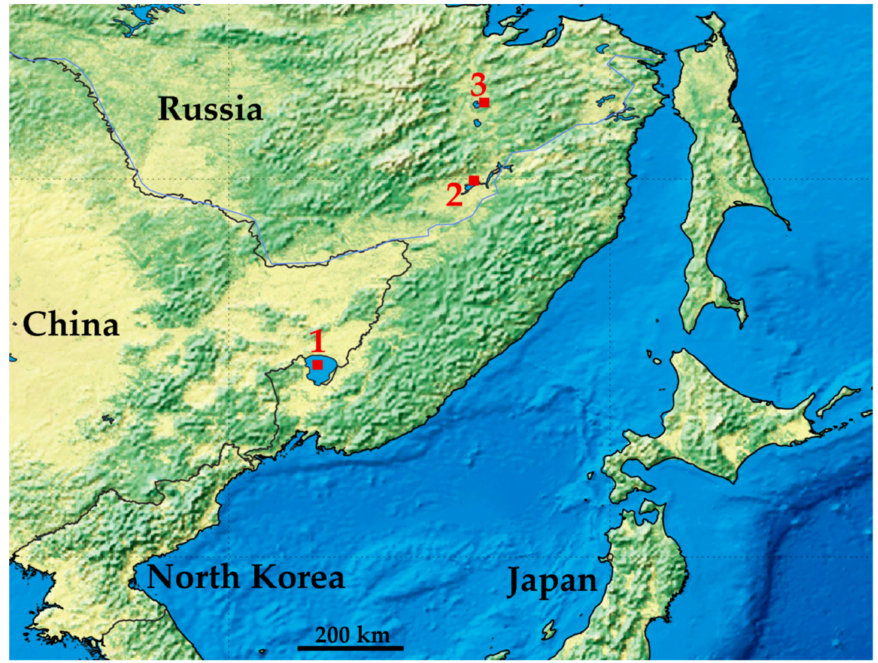
Figure 1. Map of the region, with the explored water bodies: 1—Khanka Lake; 2—Bolon Lake; 3—Chukchagir Lake. Visualization of the localities was made in the free software QGis 3.22.10 [36] using Open Access spatial GIS data from http://www.naturalearthdata.com (accessed on 1 December 2022) (Natural Earth Dataset) as the